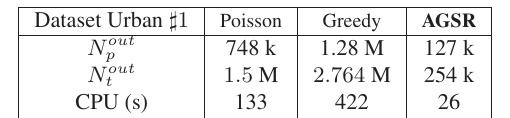
Table 4: Comparison between surface reconstruction methods: results obtained by running the algorithms on the dataset Urban and N out denote the number of vertices and the number ♯ 1 . N out p t of triangles corresponding to each output, respectively.